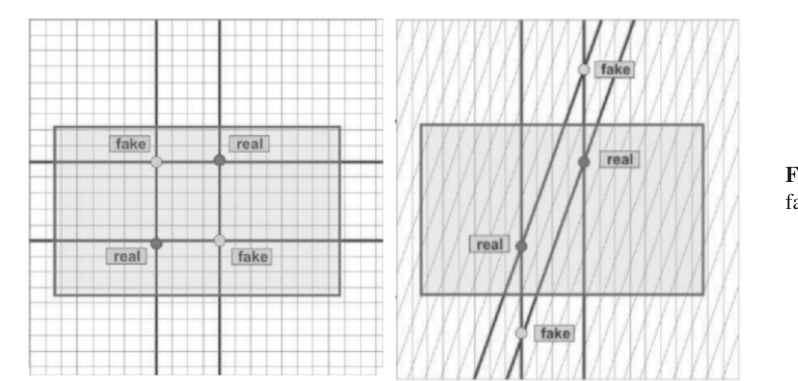
Figure 3. Scheme of fake hits production.